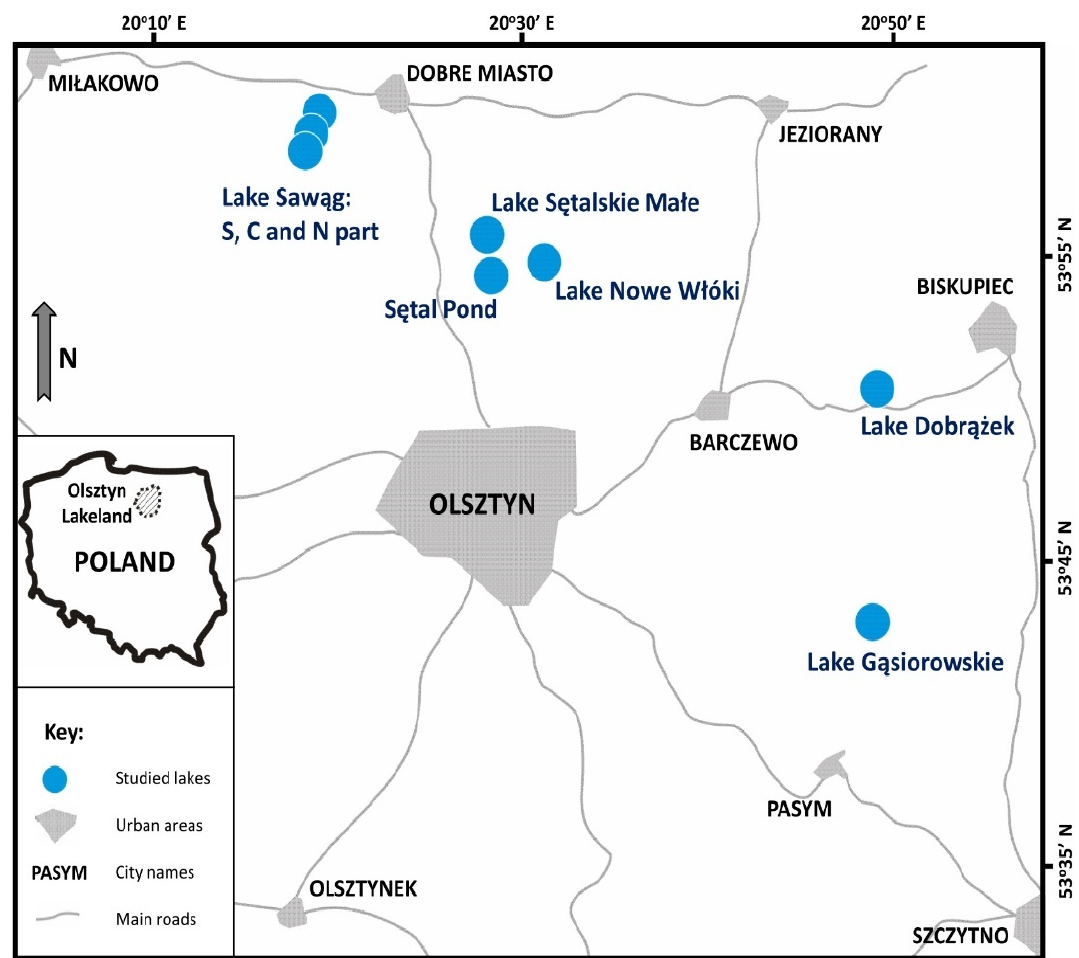
Figure 1. Research area and study sites in the Olsztyn Lakeland.